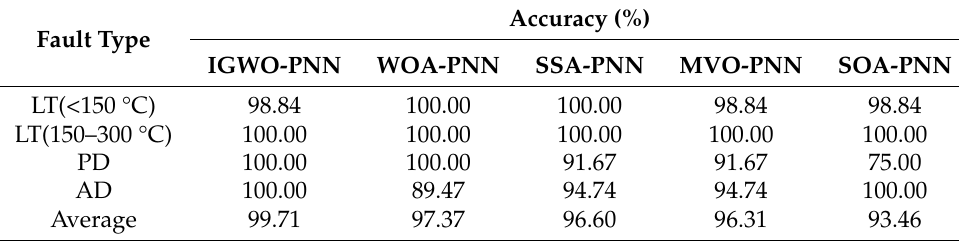
Table 6. Results of the second set of comparative